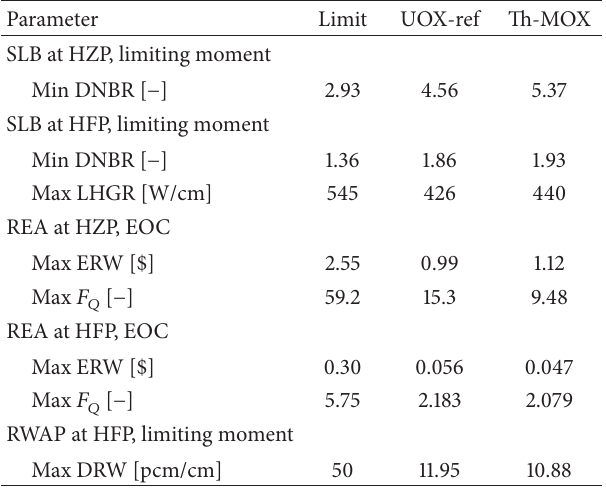
Table 3: Calculated safety parameters for the representative tran- sients SLB, REA, and RWAP. For REA, the parameters and limits are for EOC conditions. For SLB and RWAP, the same limits are employed throughout the cycle and the parameters which are listed for the moment in the cycle where they are closest to these